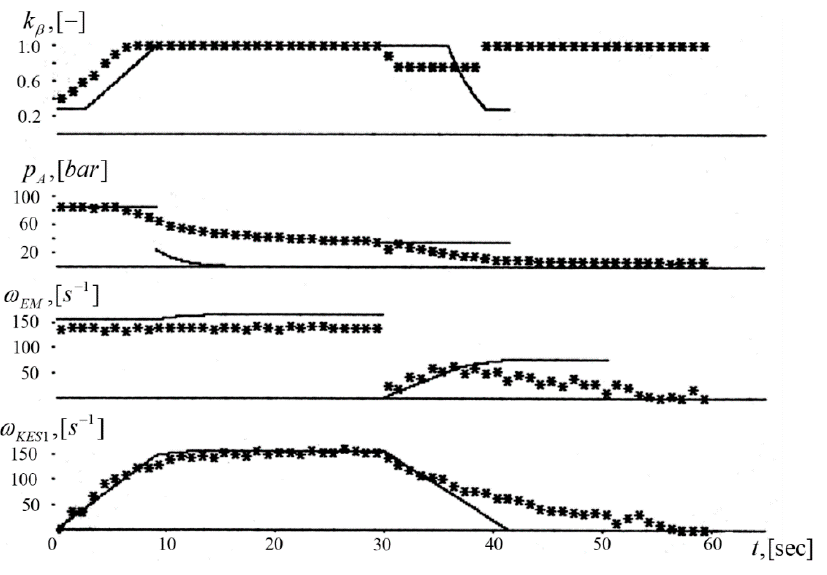
Figure 8. Comparative analysis results: approximate theoretical model—solid line; experimental data—“*”.